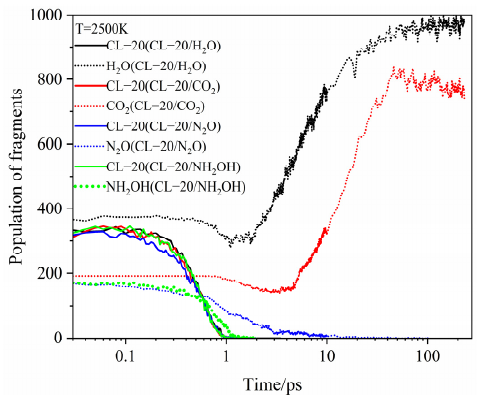
Figure 7. Evolution curves of the host and guest molecules for CL-20/H 2 O, CL-20/CO 2 , CL-20/N 2 O, CL-20/NH 2 OH at 2500 K. Thick trendline corresponds to the actual concentration data of corresponding matching color.